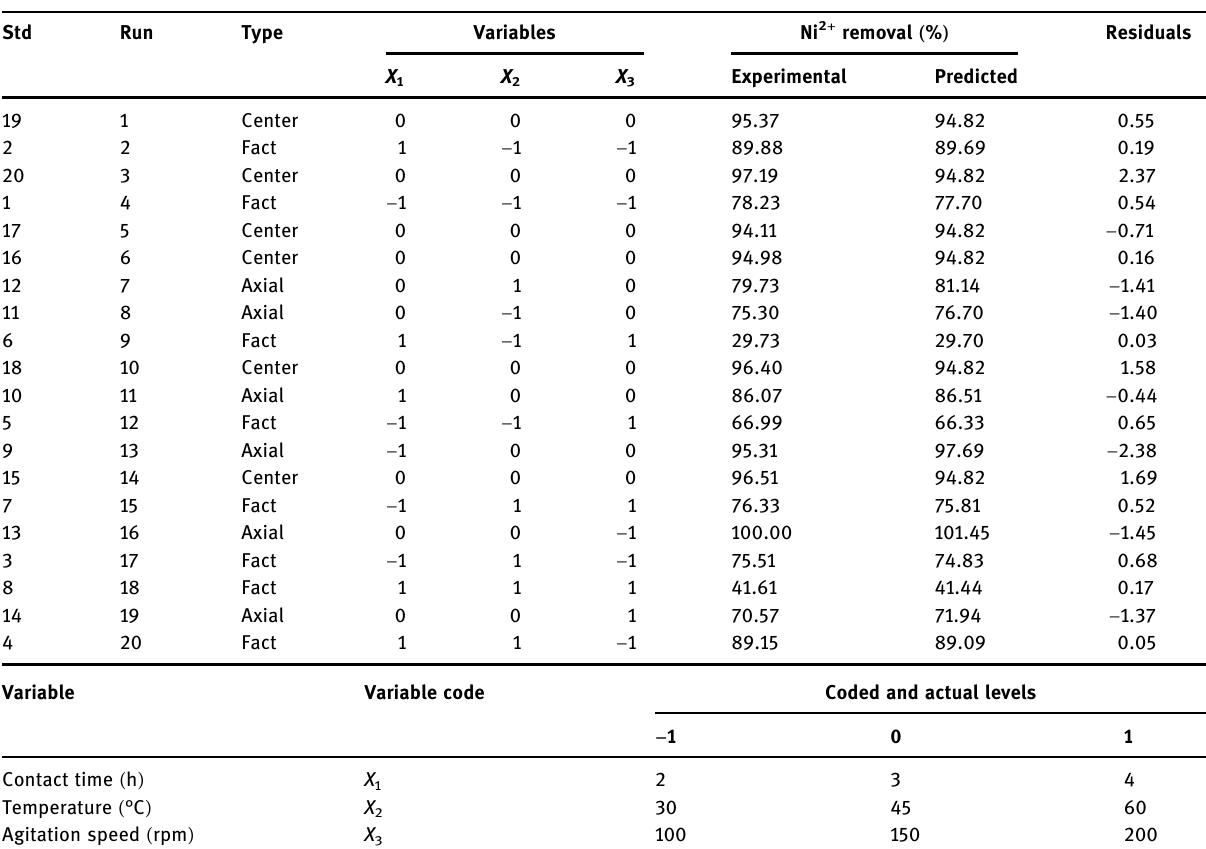
Table 3: Face - centered central composite design representing the response of Ni 2 + removal % by G. amansii as in fl uenced by contact time ( X ) , temperature ( X ) , and agitation speed ( X ) along with the predicted Ni 2 + removal % and residuals and the actual factor levels 1 2 3 corresponding to coded factor